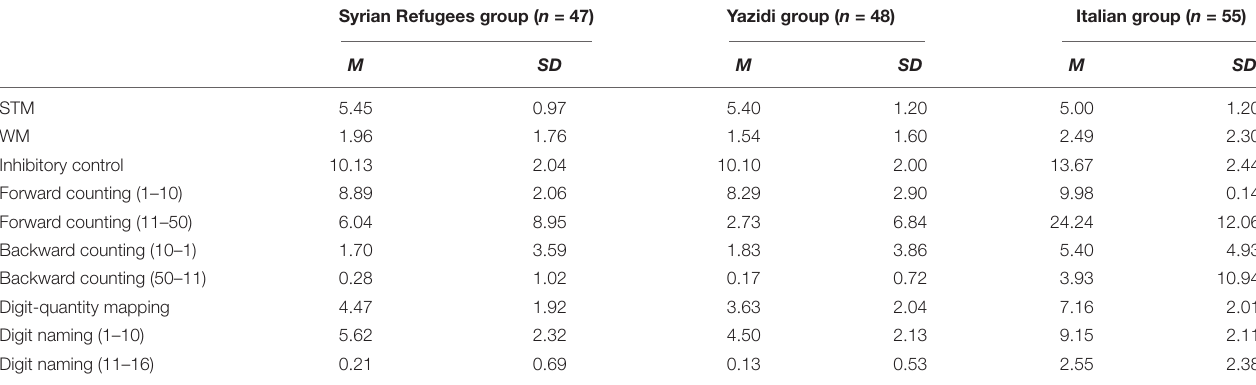
TABLE 1 | Mean scores and standard deviations in the different measures of the three groups of children (SRG, YG, and IG). Syrian Refugees group ( n = 47)